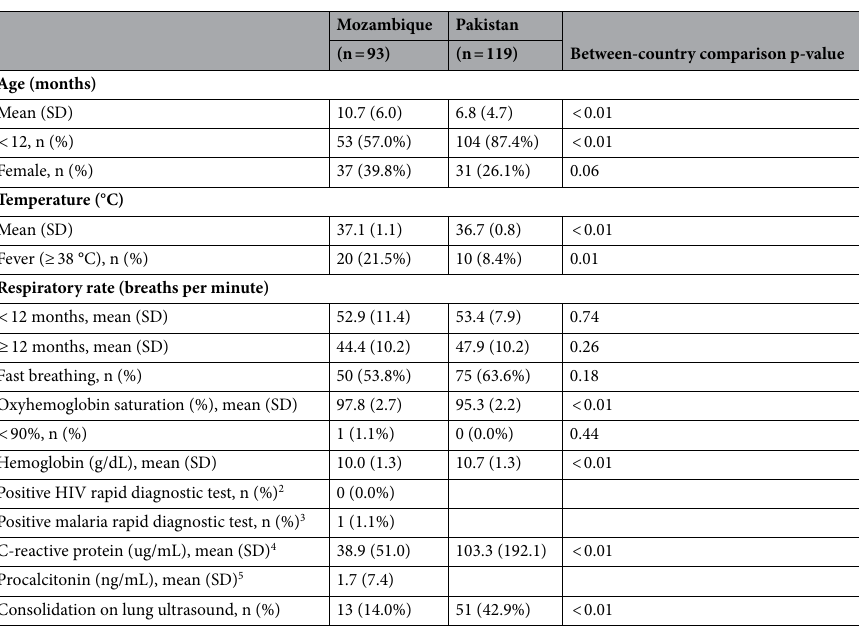
Table 2. Baseline characteristics of enrolled and analyzed 1 children in the chest-indrawing pneumonia cohort by country. SD standard deviation. 1 Baseline characteristics of enrolled children with at least 1 follow-up visit on Day 2, 6, or 14. 2 HIV testing only conducted in Mozambique; missing or indeterminate for 54 children. 3 Malaria testing only conducted in Mozambique; missing for 2 children. 4 C-reactive protein missing for 5 children in Mozambique. 5 Procalcitonin only measured in Mozambique; missing for 5 children.